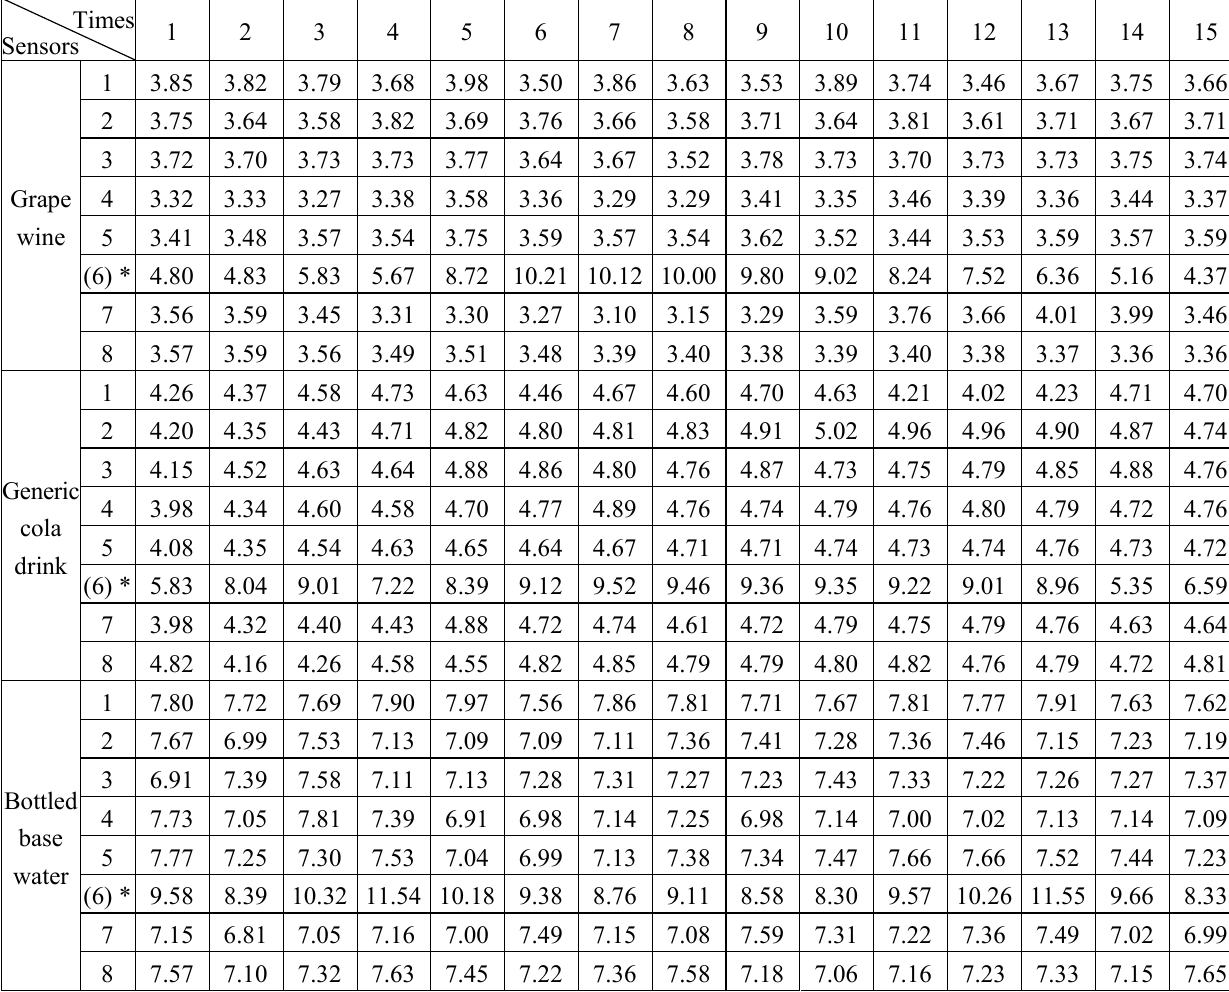
Table 1. The pH measured data of grape wine, generic cola drink and bottled base water drinks with the sensor array used for different data fusion